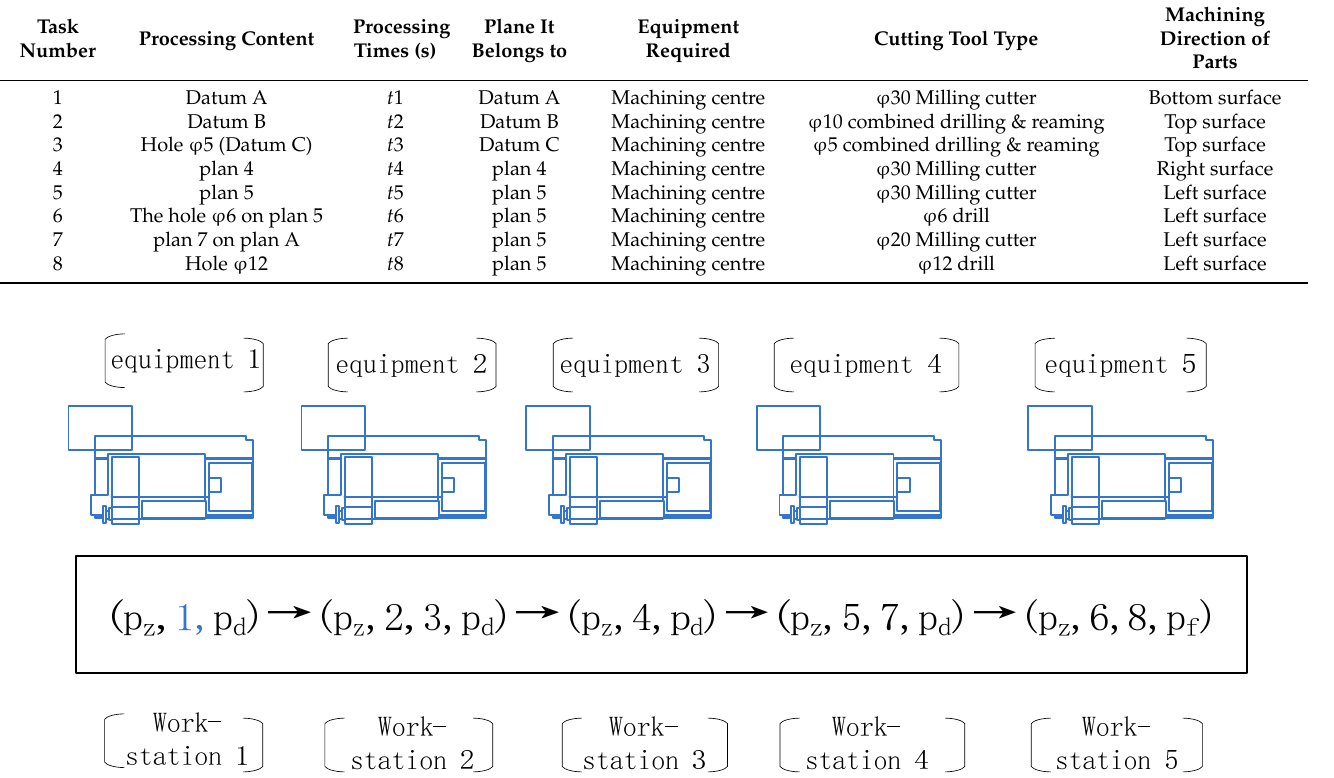
Figure 3. Process scheduling assignment scheme satisfying the constraints of Figure 2.